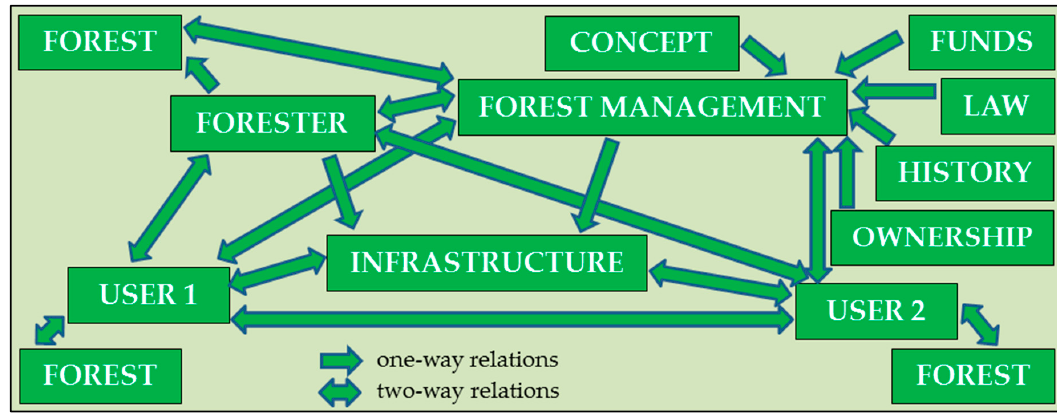
Figure 3. The complex manager-forest-user relationship in urban and suburban forests.